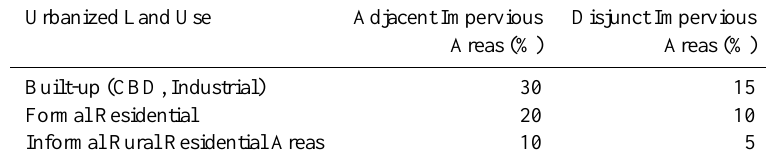
Table 5. Percentages of adjunct and disjunct impervious areas for different urbanized land uses (after Schulze and Tarboton,